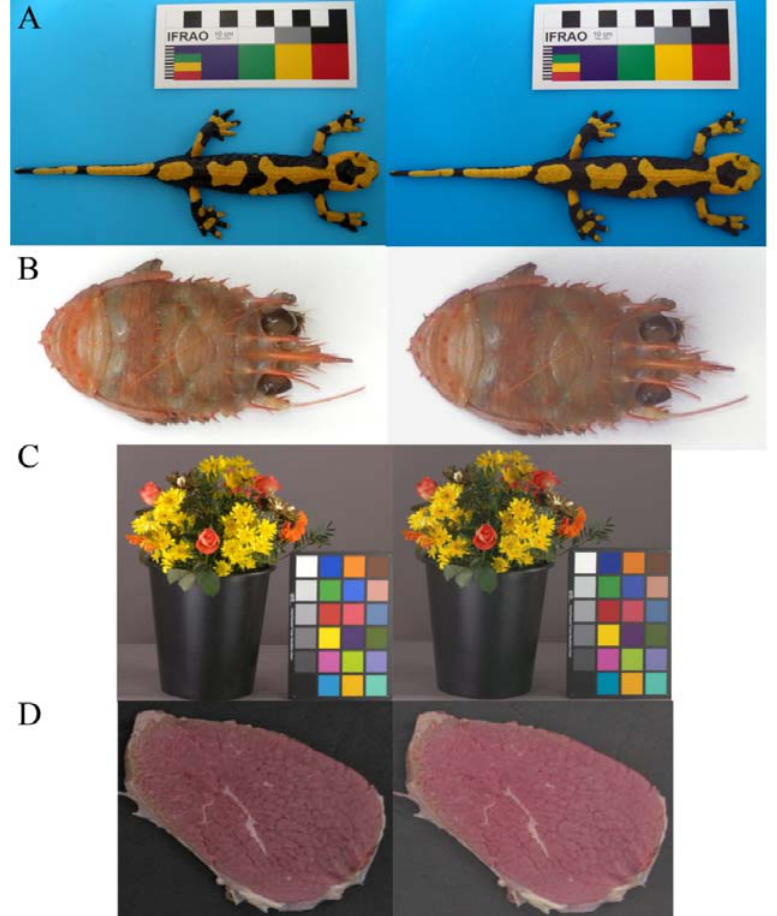
Figure 4. Four example of original (left) images and ones calibrated with the TPS-3D algorithm (right). ( A ) Salamandra salamandra ; ( B ) Munida tenuimana ; ( C ) Flower bouquet; ( D ) Beef